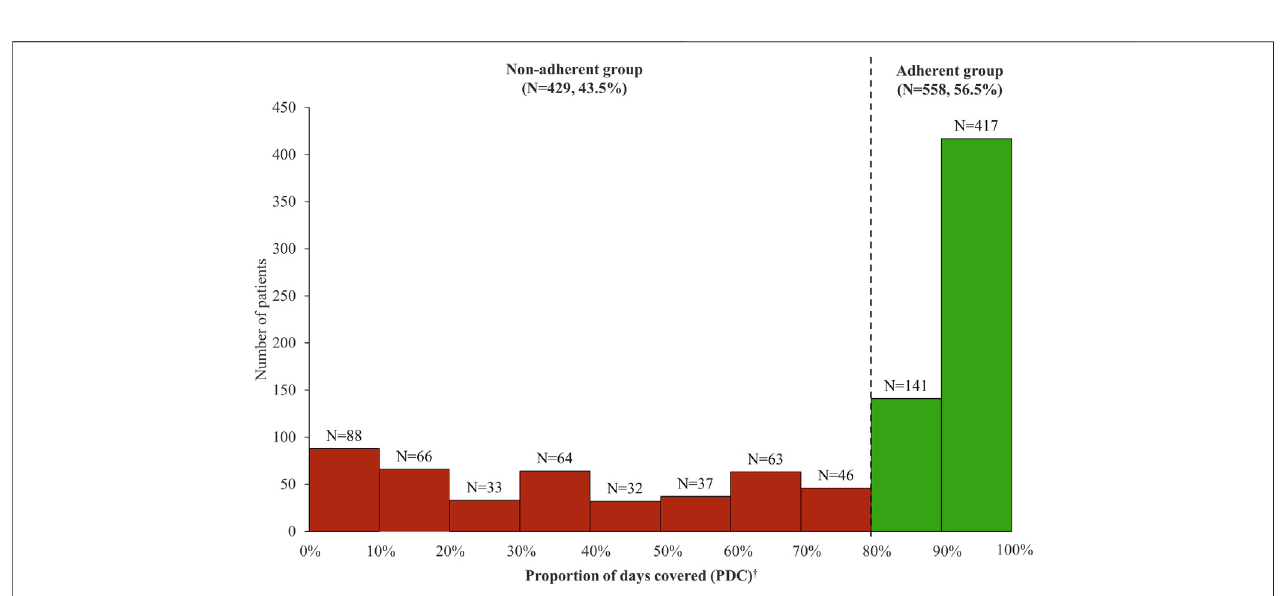
FIGURE 3 | Distribution of proportion of days covered (PDC) among patients initiating tuberculosis drug. *Mean PDC was 68.87% (standard deviation, 33.37%). † Patients with PDC ≥ 80% were classi fi ed as adherent group and patients with PDC < 80% were classi fi ed as non-adherent group.